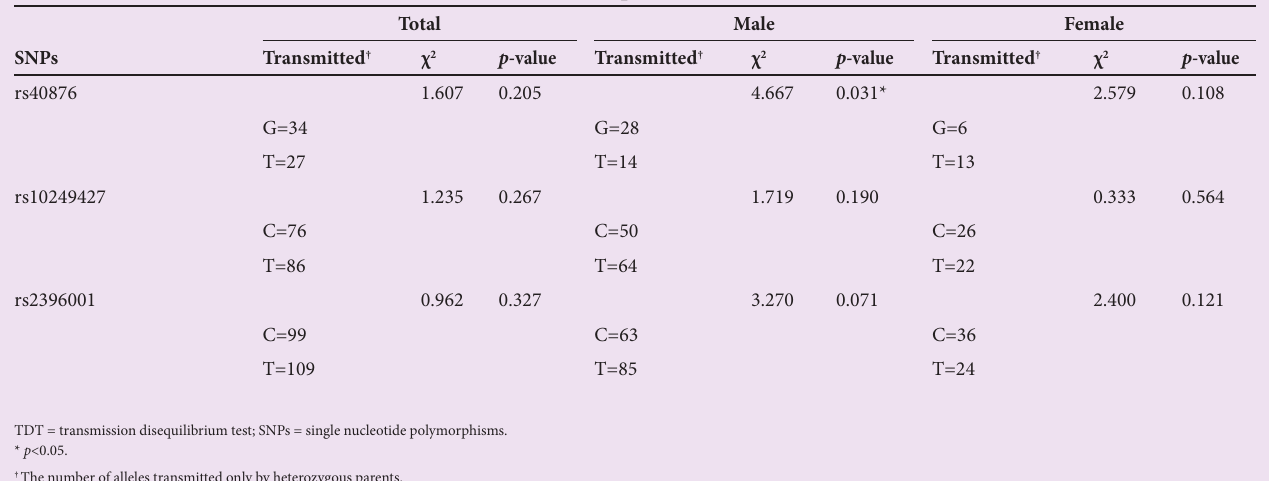
Table 1. The TDT for allelic association between SNPs and schizophrenia